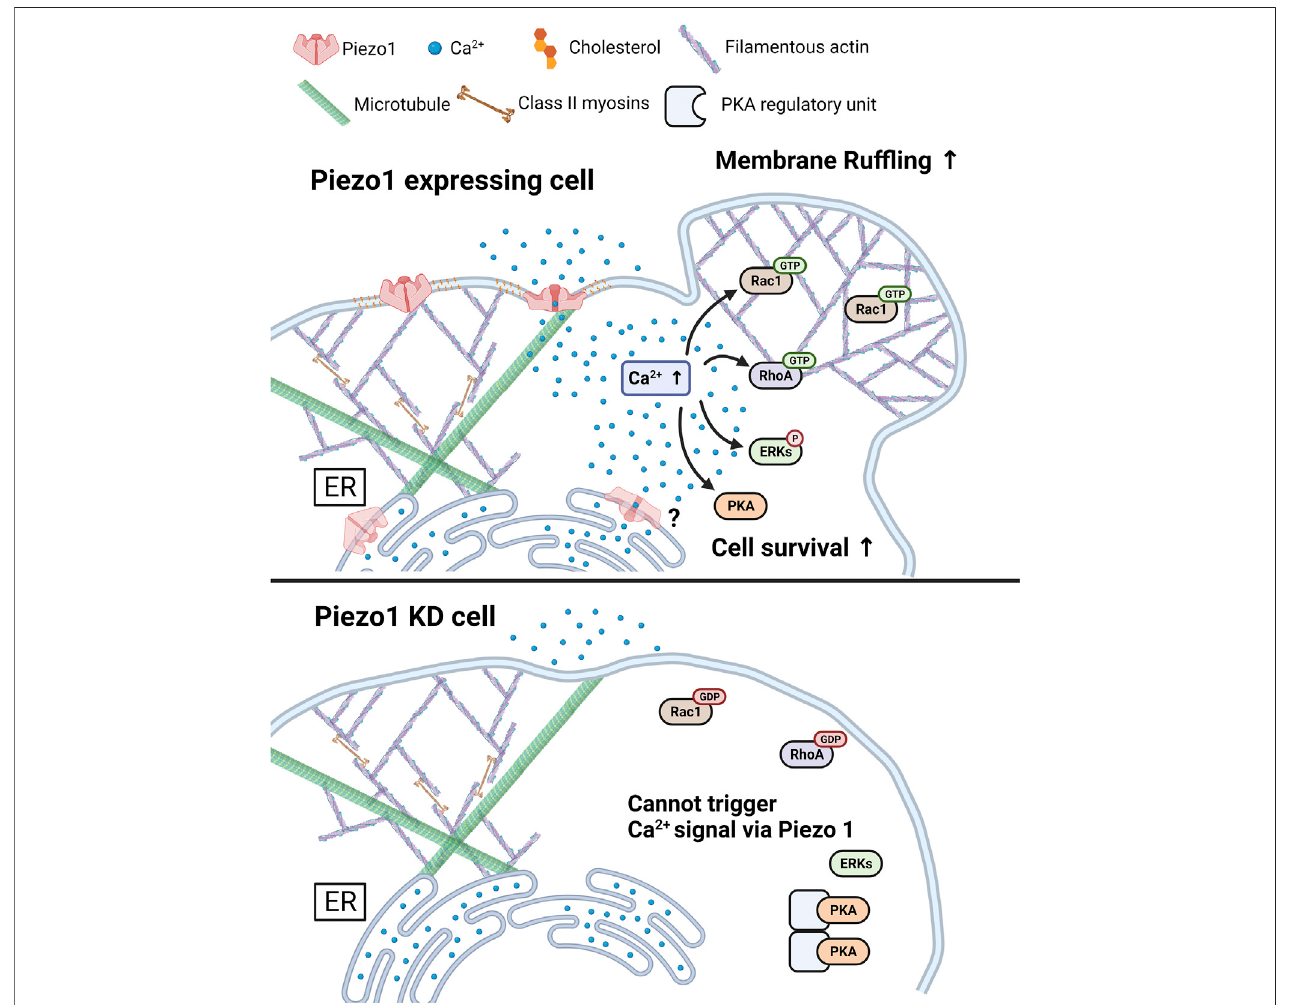
FIGURE9| A graphical summary describes the effects ofPiezo1-mediated Ca 2+ fl ux. The increase in cytosolic Ca 2+ levels inducedby Piezo1activates PKA, ERK, RhoA, and Rac1, and promotes cellsurvivaland membraneruf fl ing.Forthe normal functioning ofPiezo1,theintegrityofcaveolin, cholesterol, and cytoskeletal structure suchasmicrotubulesandactomyosinstructureswasrequired.ThePiezo1KDcellinhibitsthetriggeringofactivationofCa 2+ signal,followingcellsurvivalandmembrane ruf fl ing induced by Piezo1. The fi gure was created using BioRender.